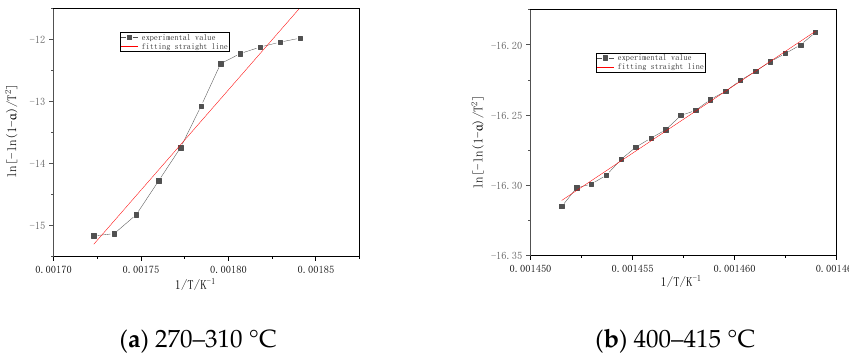
Figure 6. Fitting straight line for burning stages of Slash pine.